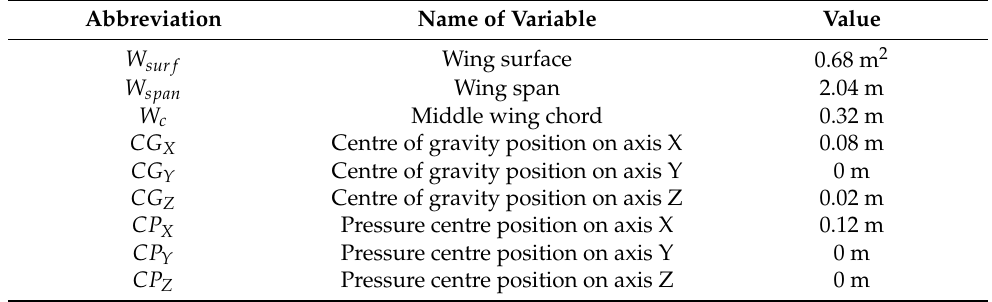
Table 1. “SkyDog” geometric